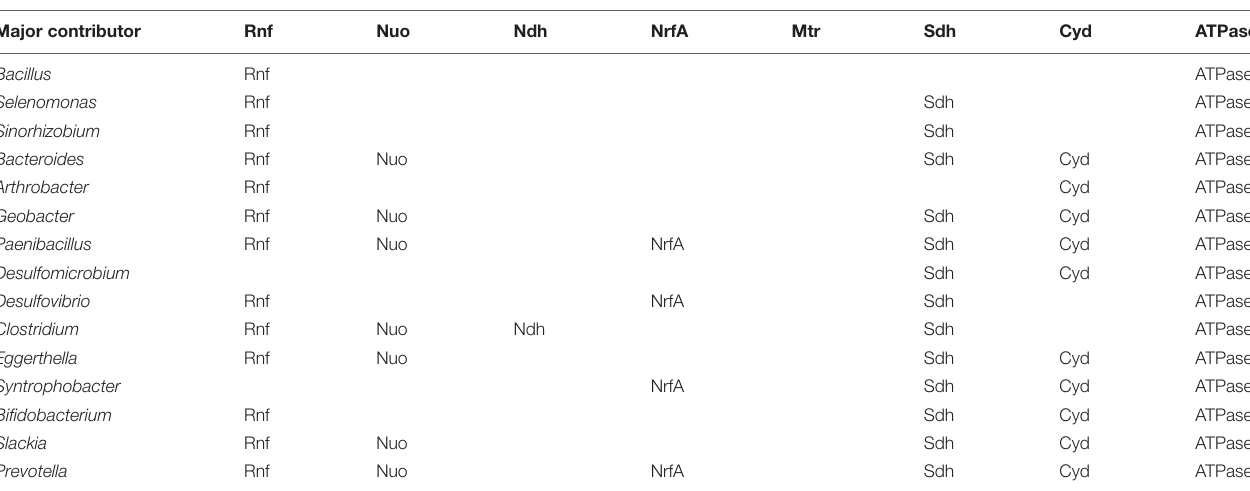
FIGURE 3 | Comparisons of the relative abundance of major contributors to F-types ATPase between the groups. The relative abundance was normalized to 1,000,000 for each sample. “ ∗ ” indicates the significant change between the G and B groups. “#” indicates the significant change between the P and B groups. TABLE 5 | Detected types of electron transporters in ETP-related